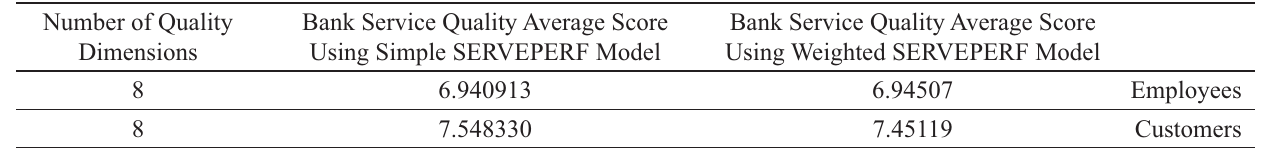
Table 5. Results of SERVPERF and weighted SERVPERF Models Number of Quality